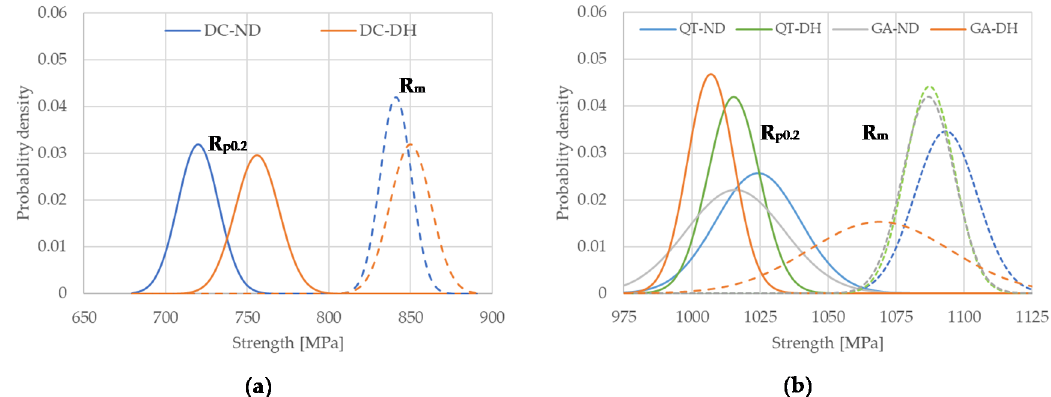
Figure 10. Probability density plot assuming Normal distribution of average strengths and their uncertainties in Table 6 as mean and standard deviation values. ( a ) Plot for the DC Class 8.8 specimens. ( b ) Plot for the QT and GA Class 10.9 specimens.